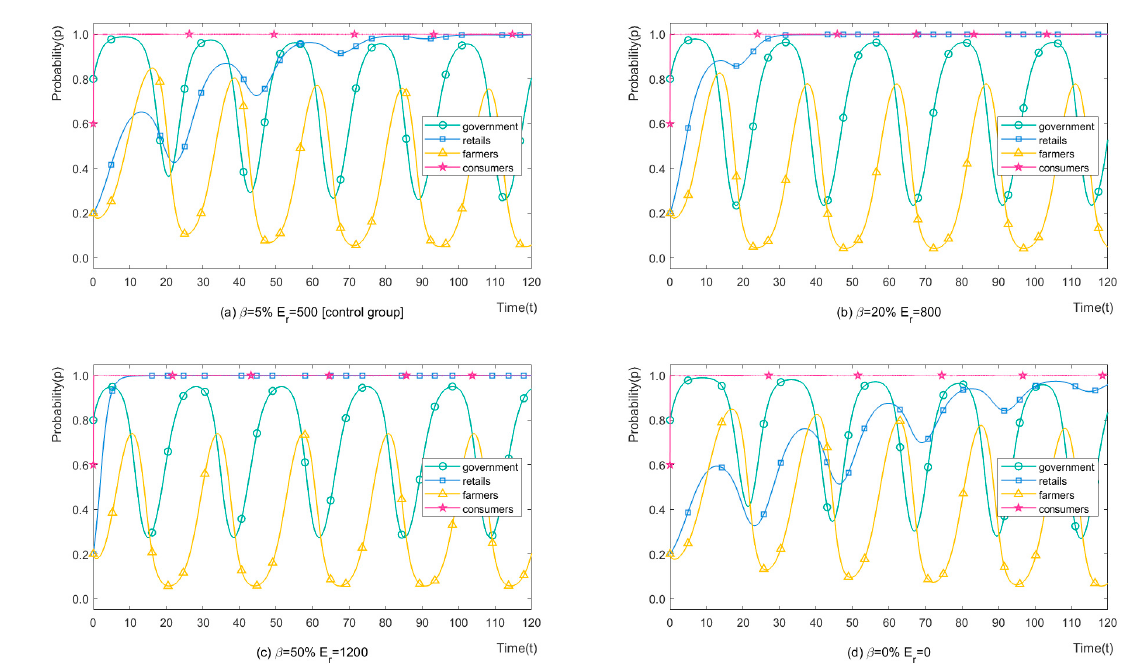
Figure 4. The strategy evolution process of stakeholders with different β and E r